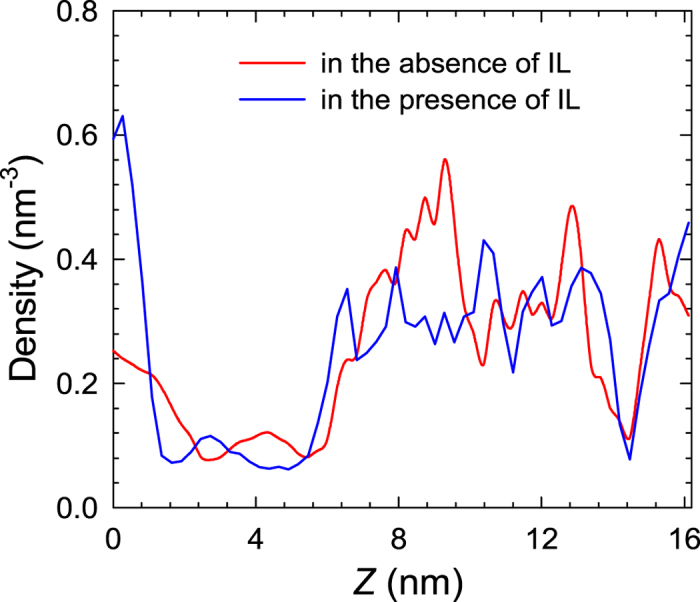
Density profiles of glucose in glucose/water/MIL-101 system in the absence and presence of [C2mim][Ac].